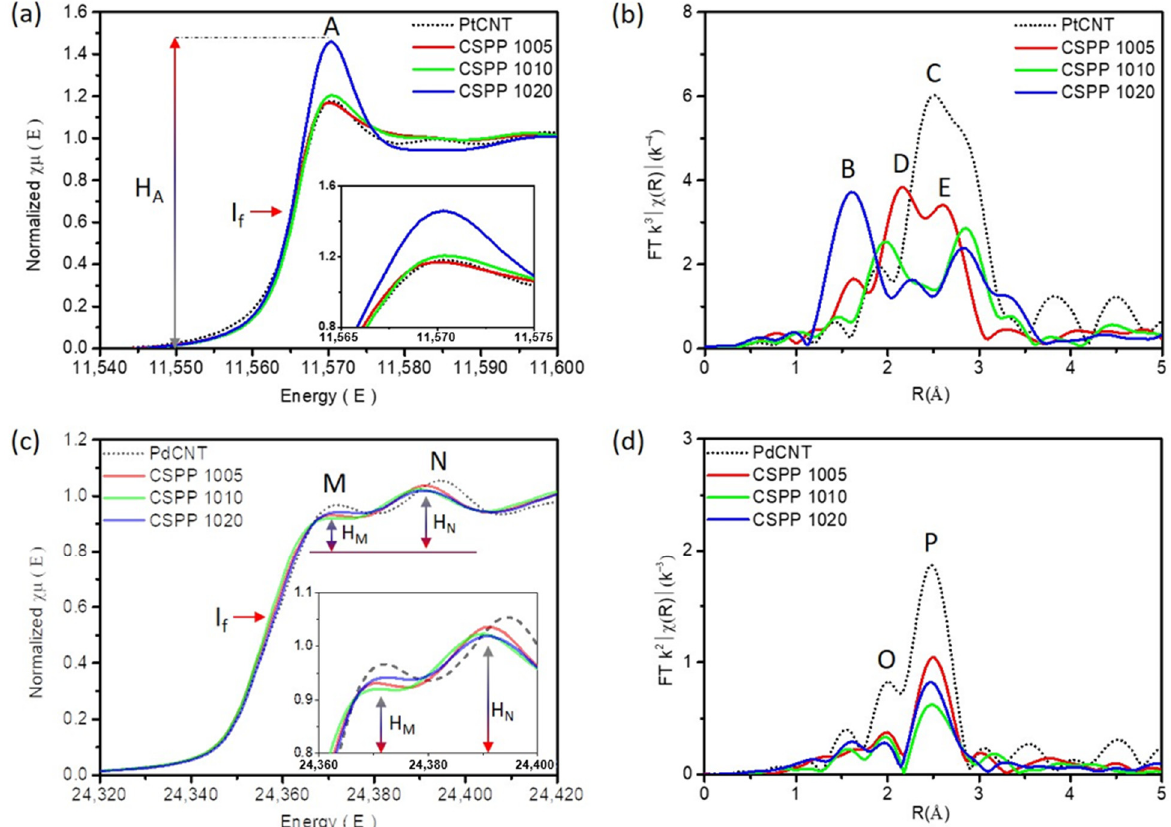
Figure 3. X-ray absorption spectroscopy of CSPP NCs and control samples. ( a ) XANES and ( b ) FT-EXAFS spectra of CSPP NCs at the Pt L 3 -edge, compared with the Pt-CNT. ( c ) XANES and ( d ) FT-EXAFS spectra of CSPP NCs at the Pd K-edge, compared with Pd-CNT.